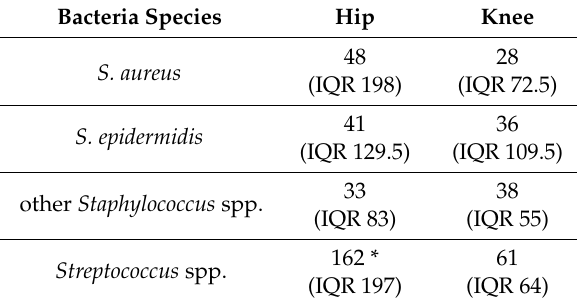
Table 2. Time (median value in months) elapsed since primary prosthetic joint replacement; IQR (interquartile range).